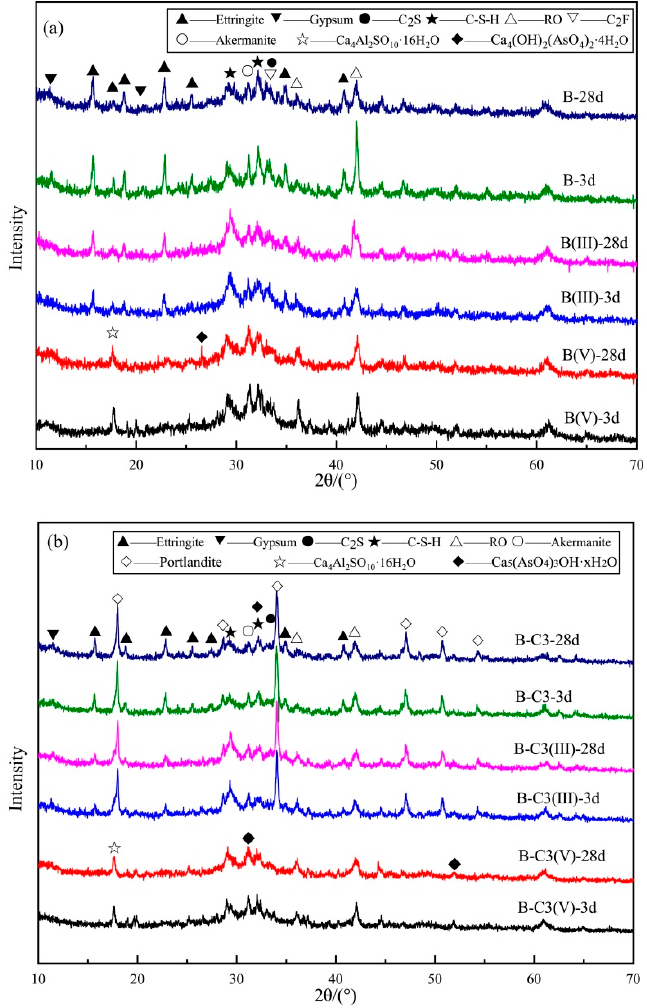
Figure 2. The XRD patterns of ( a ) B, B(III) and B(V) paste; ( b ) B-C3, B-C3(III) and B-C3(V)